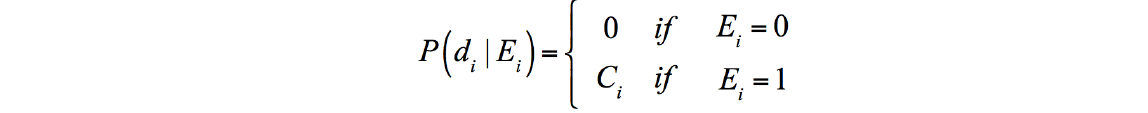
Figure 5. Probability to fall given exposures and contributions.